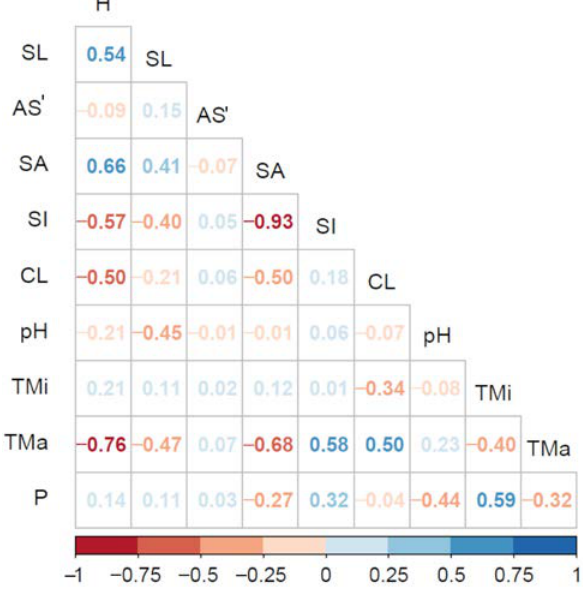
Figure 8. Correlogram relating all the standardized values of considered discriminants.